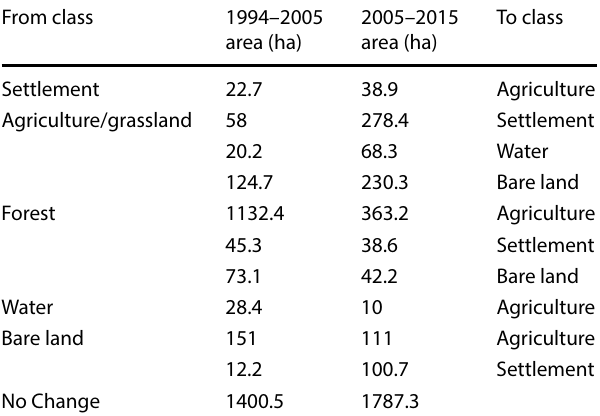
Table 6 Significant land cover transitions from 1994 to 2015 From